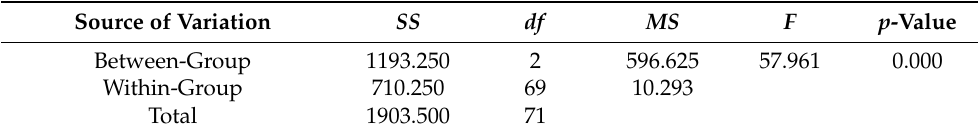
Table 6. One-way ANOVA (analysis of variance) for the effects of VSIDCS, MoCA, and MMSE on